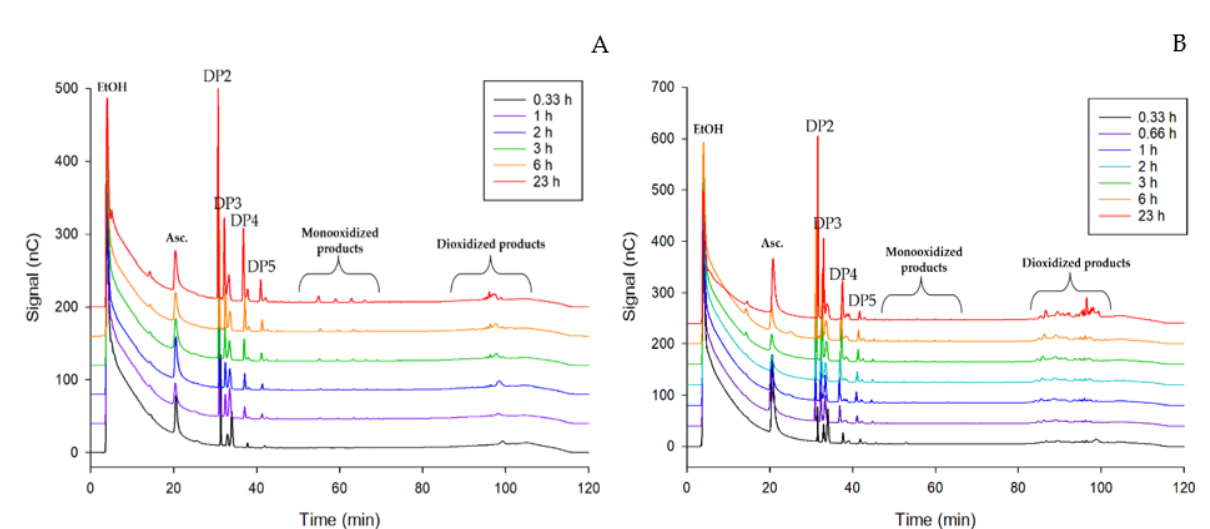
Figure 6. ( A ) HPAEC-PAD elution profile of PASC degradation samples after incubation with TamAA9A-WT. Reaction conditions: 1% ( w / v ) phosphoric acid swollen cellulose (PASC), 100 mM phosphate buffer (pH 6.0), 1 mM ascorbic acid, 20 µ g/mL of LPMO, and 30 ◦ C. ( B ) HPAEC-PAD elution profile of CMC degradation samples after incubation with TamAA9A-WT. Reaction conditions: 1% ( w / v ) carboxymethyl cellulose (CMC), 100 mM phosphate buffer (pH 6.0), 1 mM ascorbic acid, 20 µ g/mL of LPMO, and 30 ◦ C. Structures of the potentially obtained products can be seen in the Figure 1 in the introduction section.